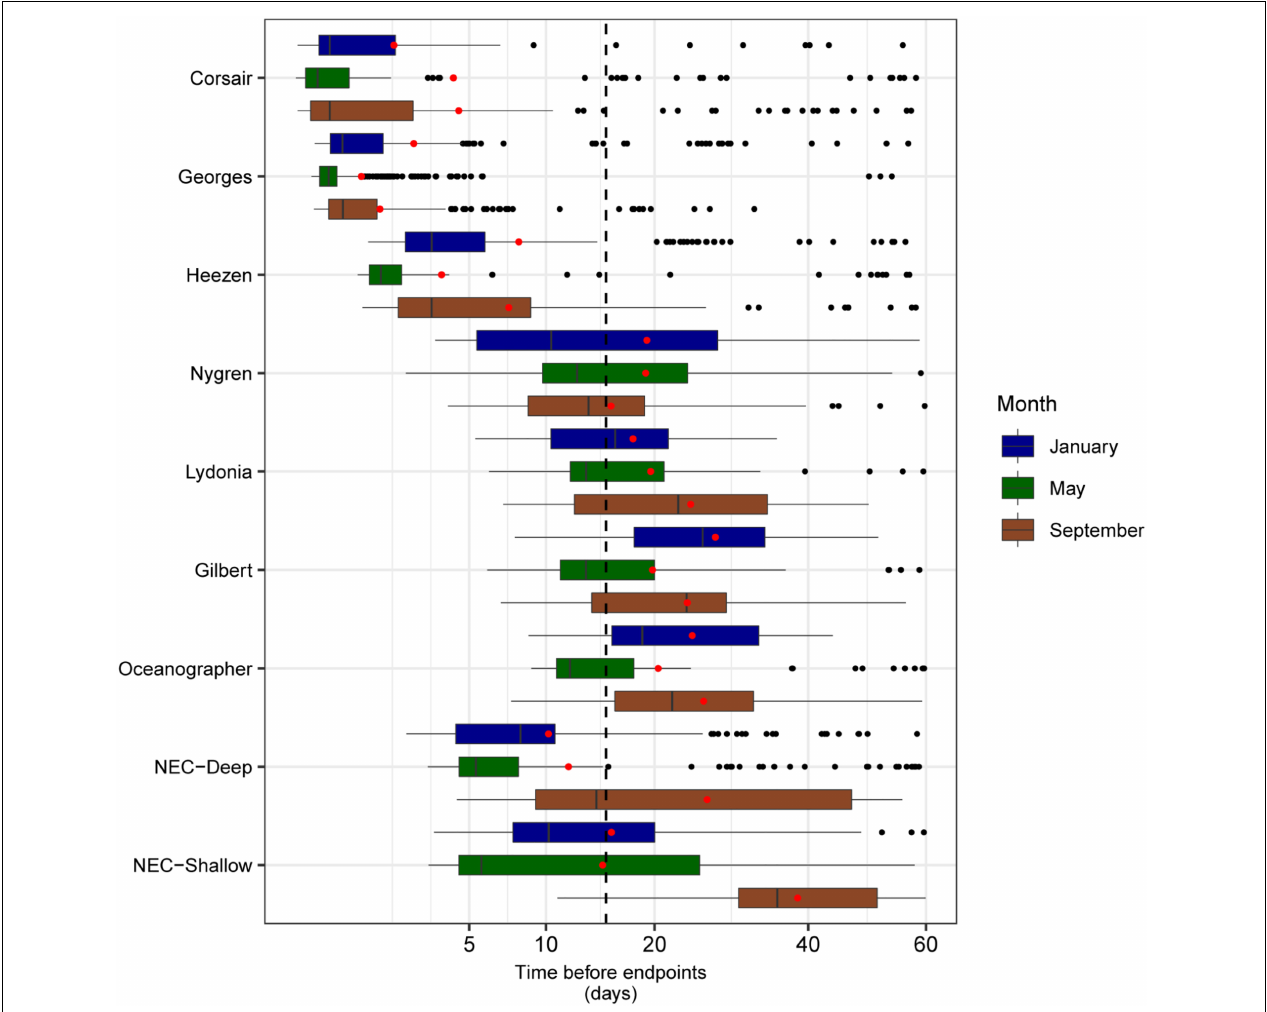
FIGURE 10 | Boxplots of mean minimum transit time calculated from all tracks overlapping each zone of interest, segregated by month (sample sizes for the zone-month combinations are given in Table 4 ). Mean transit times for each month-zone combination (red diamonds) and overall average (black dashed line) are also